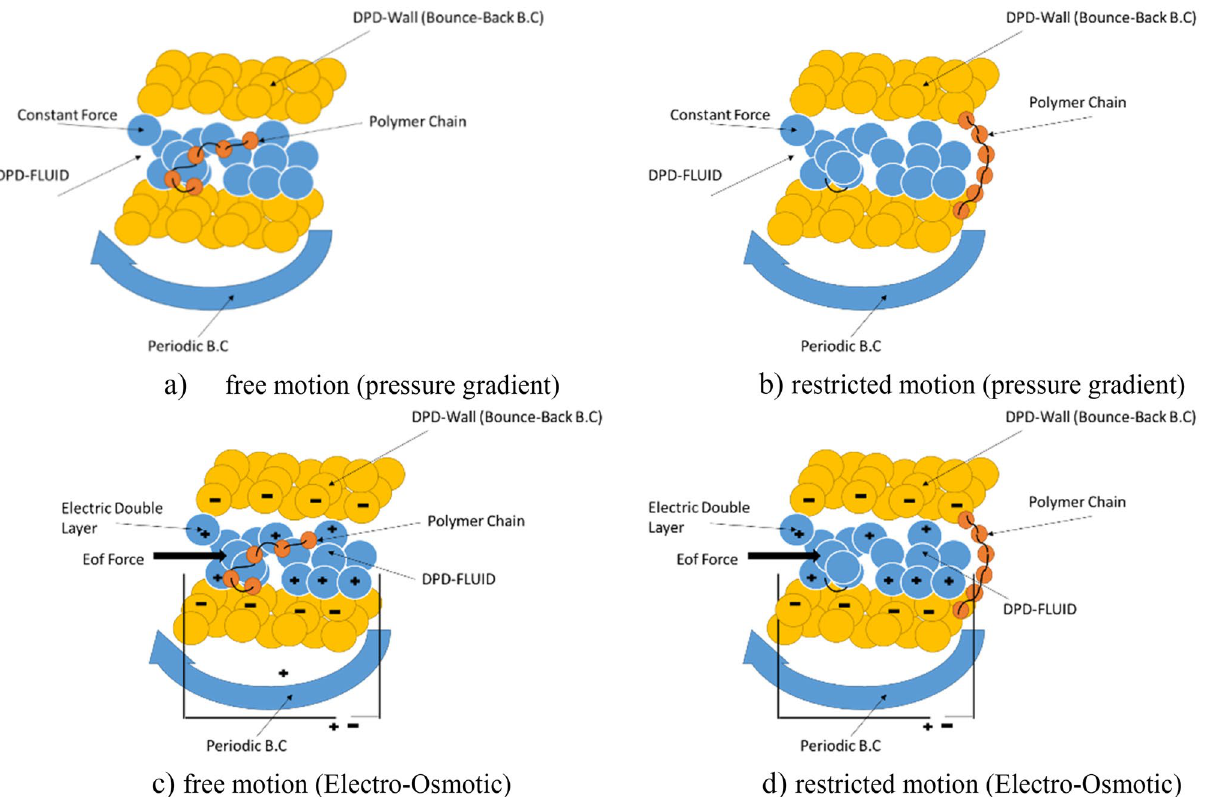
Figure 1. Schematic of DPD particle motion in a channel with periodic and bounce-back boundary condition and presence of polymer chain in nanochannel in two cases of free motion ( a,c ) and restricted motion of polymer chain ( b,d ) for pressure gradient and electroosmotic